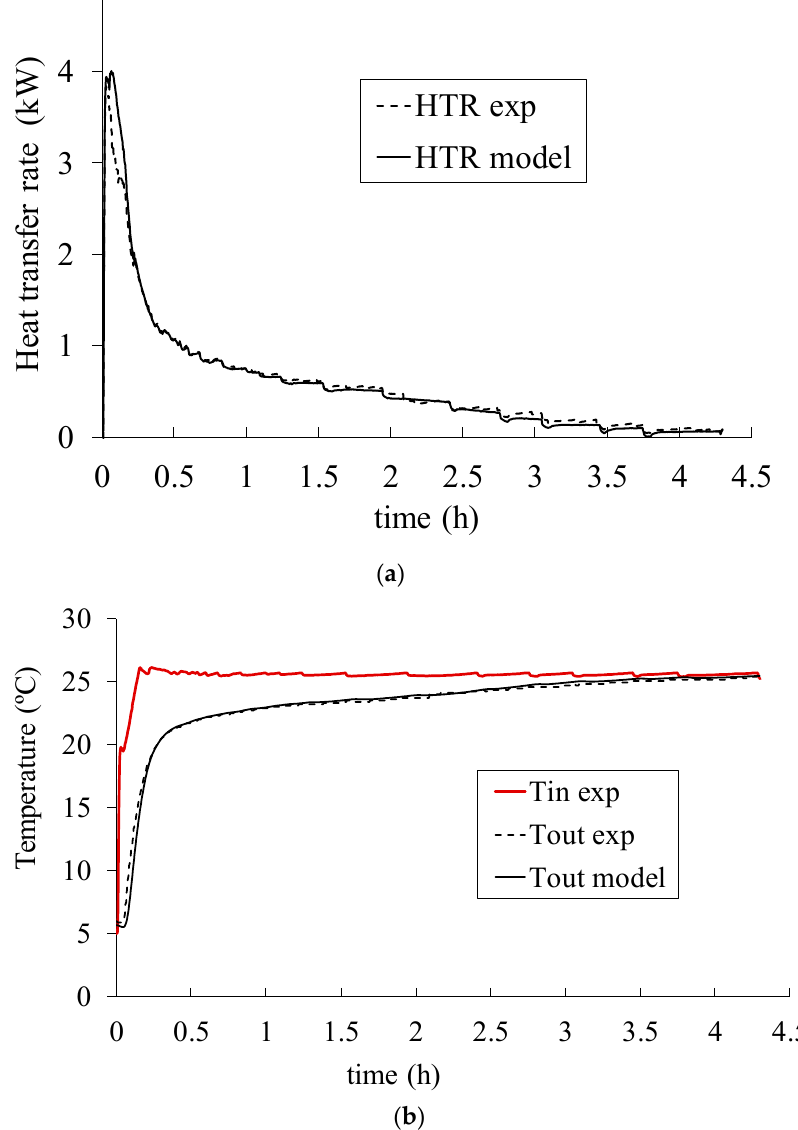
Figure 5. Comparison between experimental and numerical results of the HTF vs. ( a ) heat transfer rate and ( b ) outlet temperature.